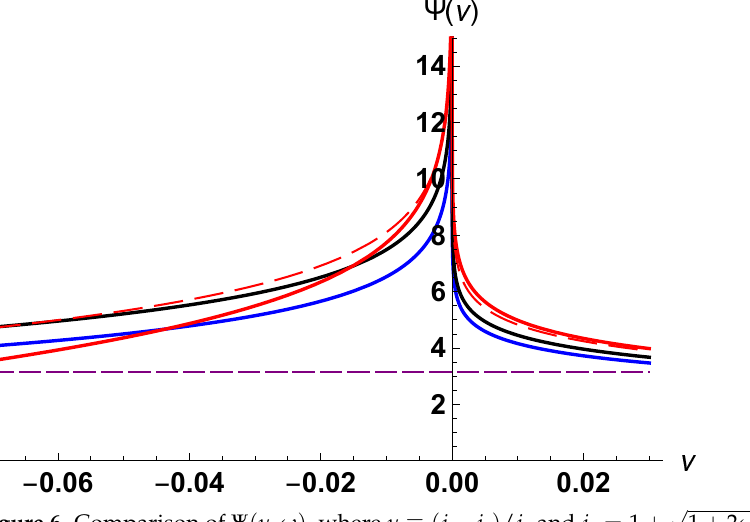
Figure 6. Comparison of Ψ ( ν , ω ) , where ν ≡ ( j − j c ) / j c and j c = 1 + values ω = − 1 (red), ω = − 1 (red dashed), ω = 0 (black), and ω = + 1 3 4 line show the Newtonian periastron Ψ N = π